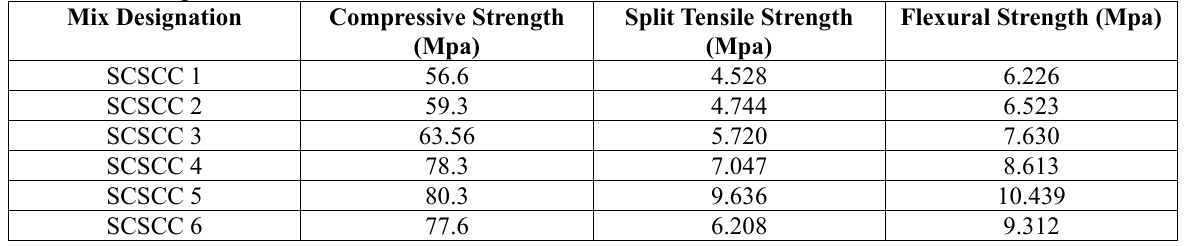
Mechanical Properties of PEG